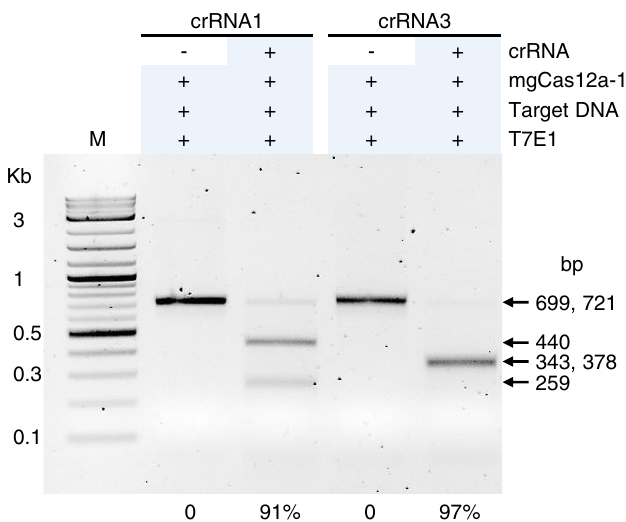
Figure 7. A mgCas12a-1 ribonucleoprotein successfully edits the CCR5 gene in HEK293 cells. ( a ) Schematic diagram illustrating target sites of the CCR5 gene. Solid lines indicate the locations for genomic DNA (top) and the exon 3 of the CCR5 gene. The forward and reverse primers are denoted on the top and bottom of the genomic DNA with short lines. Substrate DNA amplified with F1 and R1 primers is cut into 259 and 440 bp DNA when digested by mgCas12a-1-HsCCR5_crRNA1 enzyme. The 721 bp long DNA is cut into 378 and 343 bp DNA when cut by mgCas12a-1 with HsCCR5_crRNA3. The crRNA sequences for HsCCR5_crRNA1 and 3 are shown. Red-colored font is for spacer RNA. ( b ) T7E1 analysis of the PCR-amplified DNA. The PCR products amplified by using F1–R1 for crRNA1 and F3–R3 for crRNA3 are shown. When RNPs with each crRNA were treated with the HEK293T cells, T7E1 endonuclease successfully cut the DNA into two pieces as indicated. The editing efficiency measured by ImageJ software is indicated at the